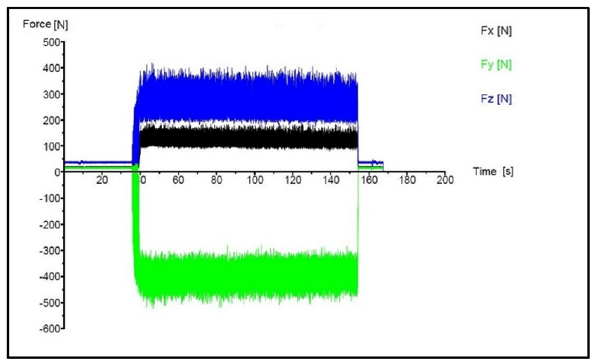
Figure 7: Forces on the tool without an applied magnetic fi eld ( HSS -